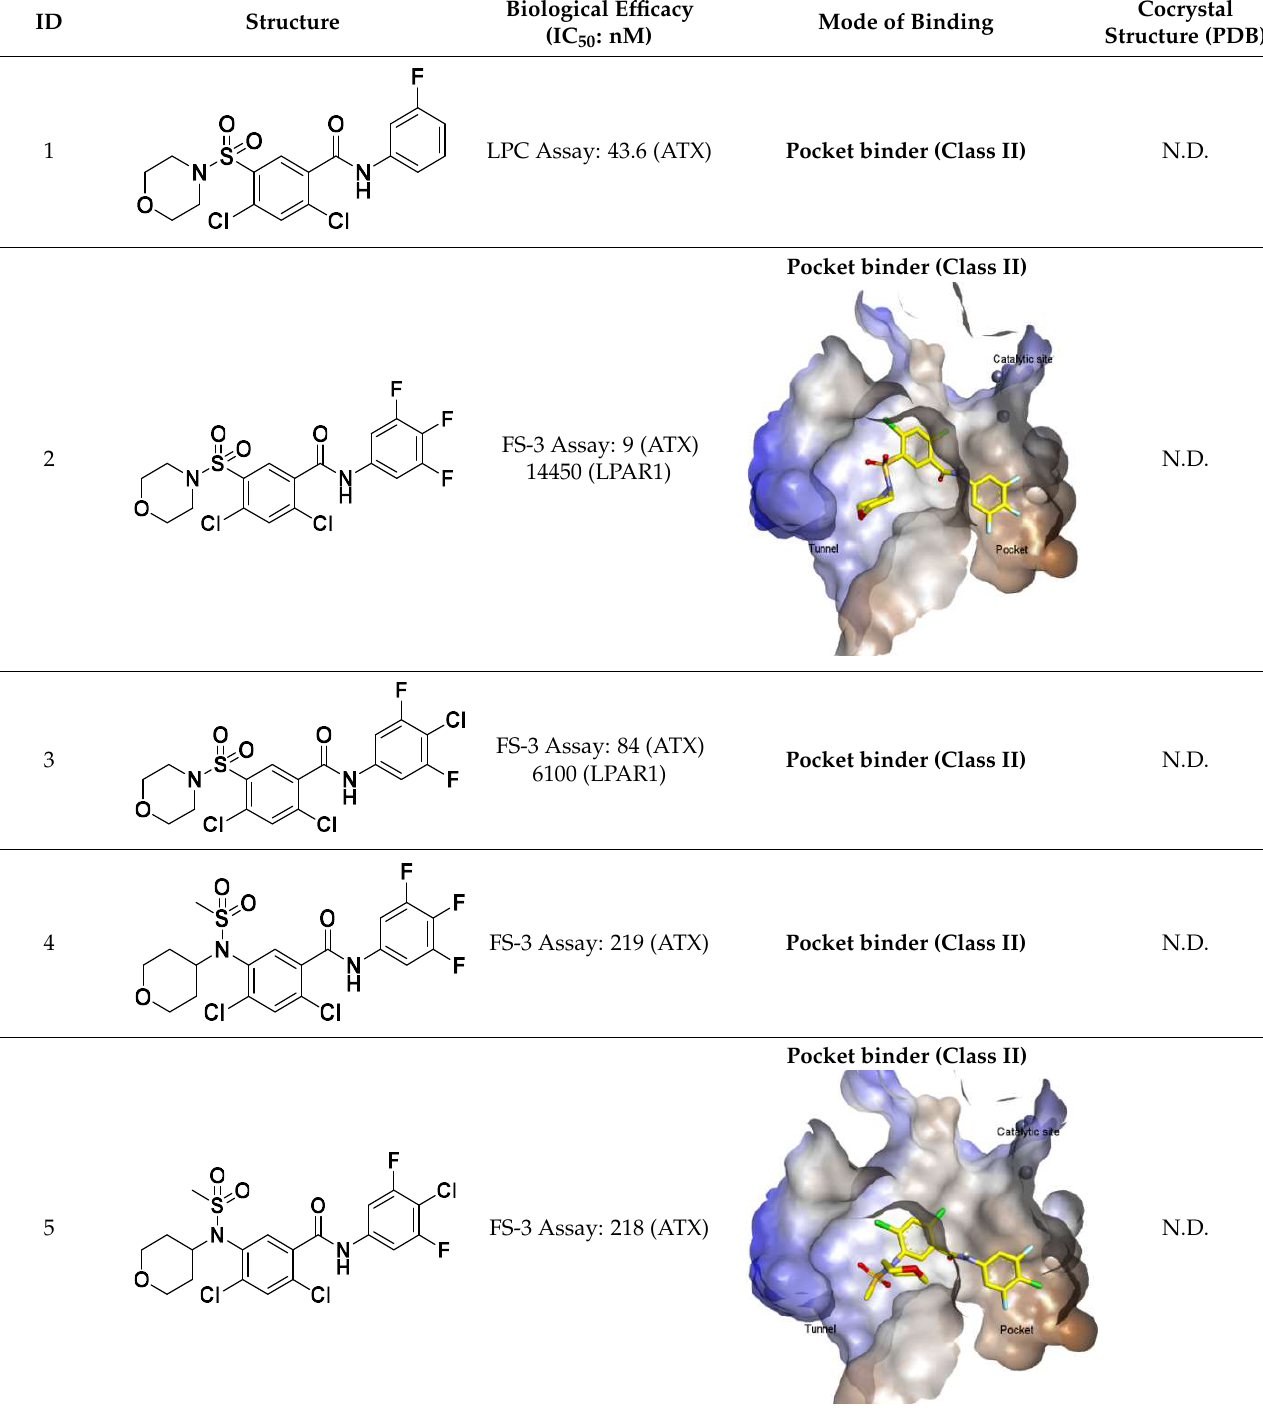
Table 1. Potent ATX inhibitors targeting hydrophobic pocket and tunnel.